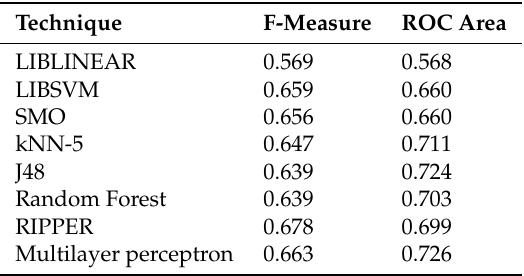
Table 11. Weighted average values of F-Measure and Receiver Operating Characteristics (ROC) area for all methods (10-fold